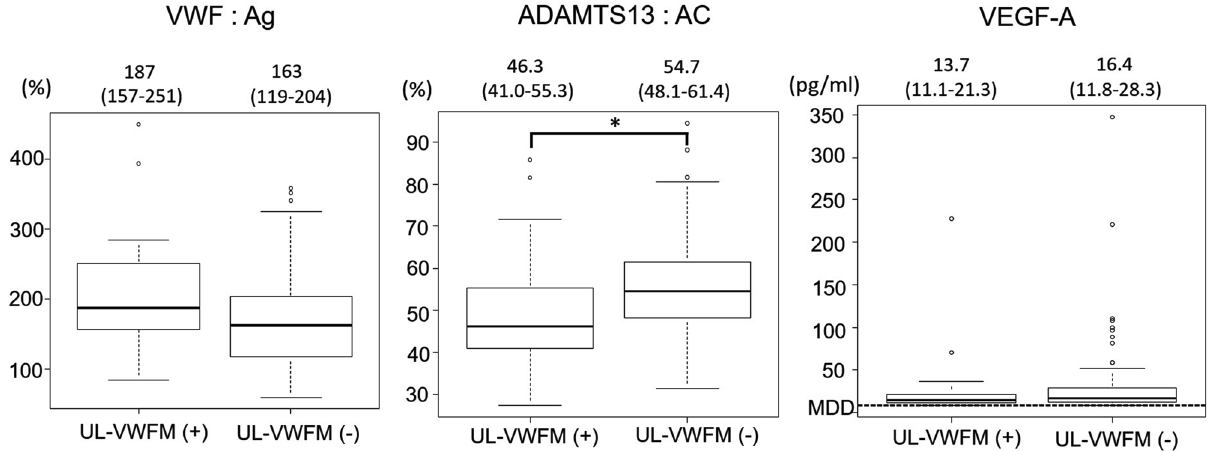
Figure2. VWF: Ag, ADAMTS13:AC, and VEGF-A in UL-VWFM (+) and UL-VWFM (−). Each of the values in the graph is the median with the interquartile range. The ADAMTS13:AC was significantly lower in